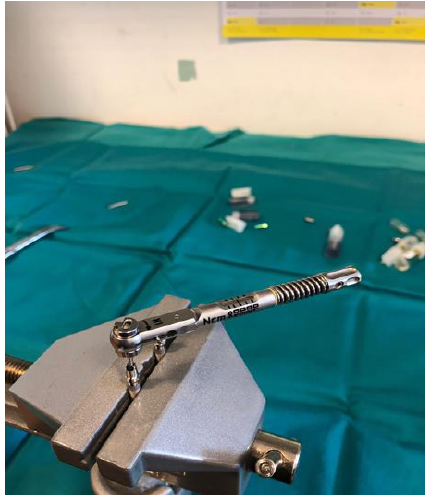
Figure 6. Tightening a prosthetic abutment.